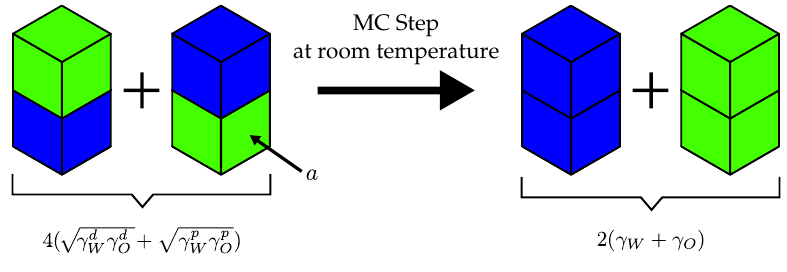
Figure 3. Example MC step in a water–oil mixture as explained in the text. The neighbouring particle exchange step is performed at room temperature, i.e., k B T = 2.48 kJ/mol. The interfacial area for each type of interface is a .